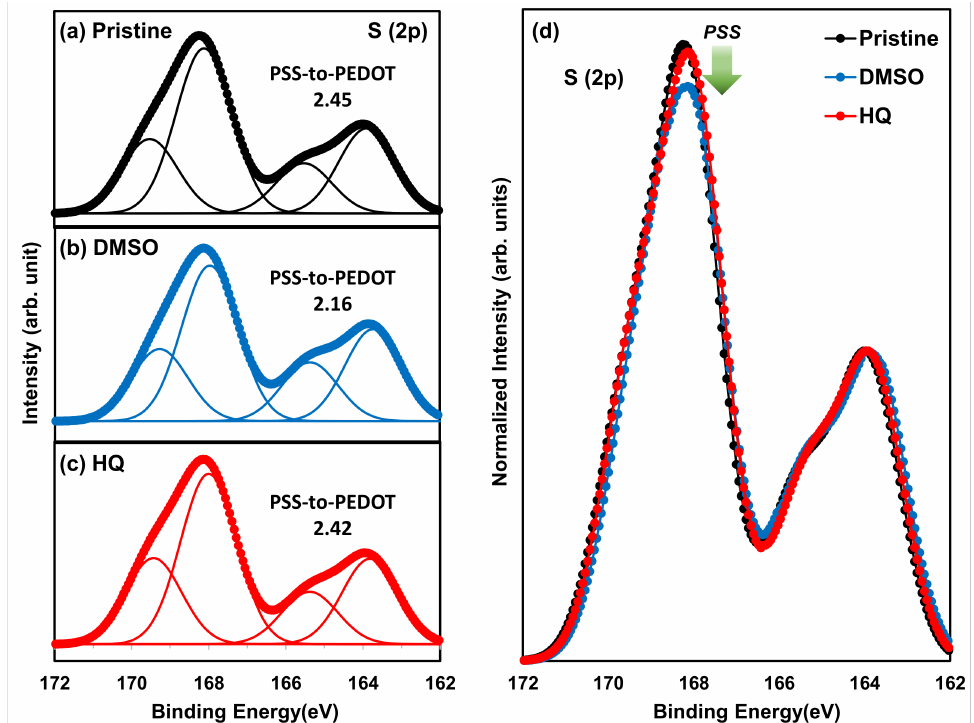
Figure 6. S (2p) XPS results of PEDOT:PSS: ( a ) pristine ( b ) DMSO ( c ) HQ and ( d ) relative comparison of peak